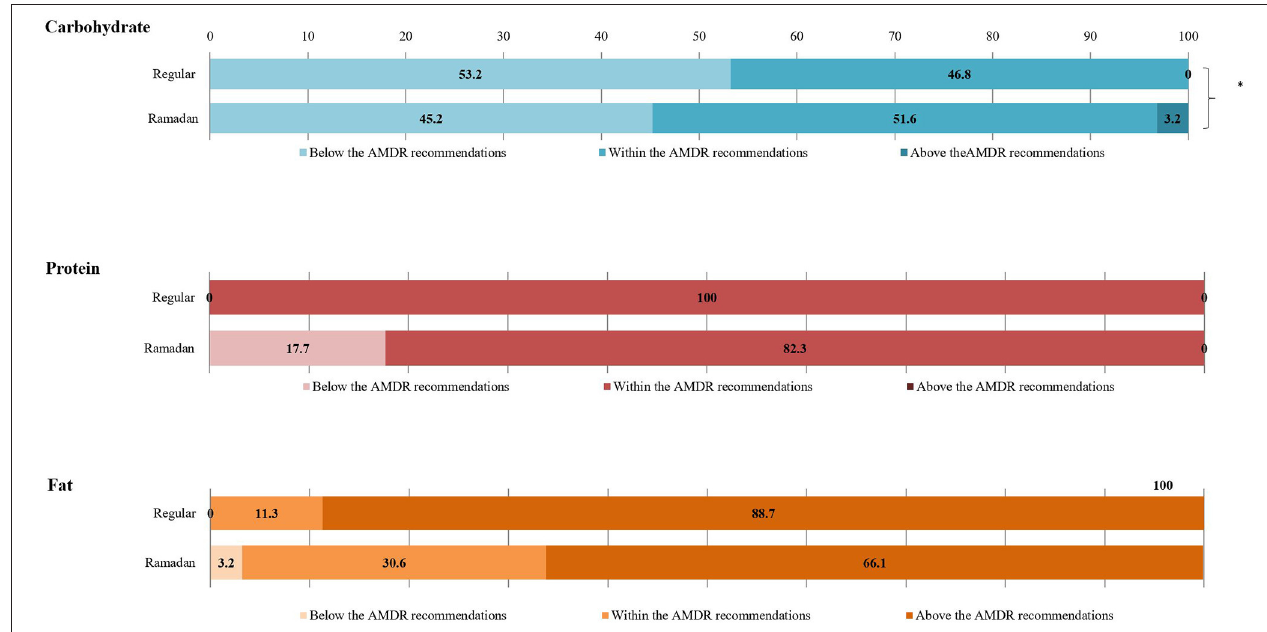
FIGURE 2 | Comparison of the proportions of participants meeting the AMDR recommendations for macronutrients between regular days and the month of Ramadan among study participants ( n = 62). The ‘*’ denoted a statistically significant difference at